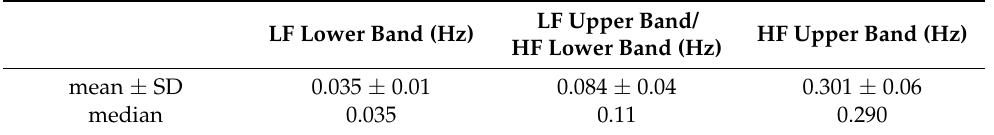
Table 5. The bandwidth of the best correlation coefficient in each patient (low frequency [LF] and high frequency [HF]).